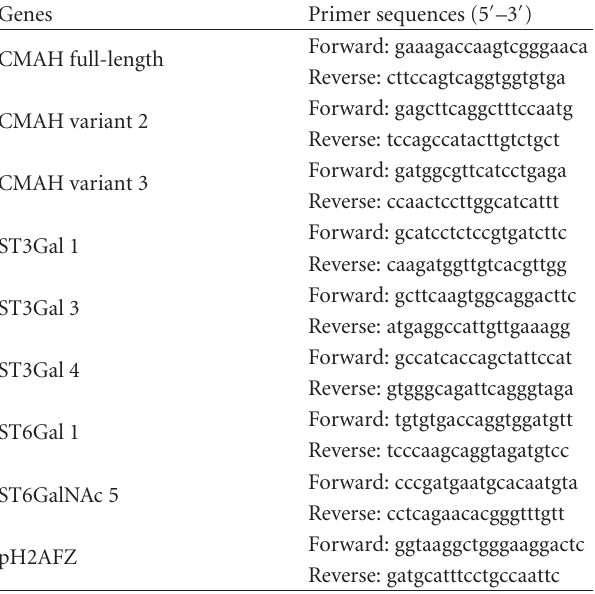
Table 1: Primer sequences used for real-time reverse transcriptase- polymerase chain reaction (RT-PCR). Genes Primer sequences (5 (cid:3) –3 (cid:3) )